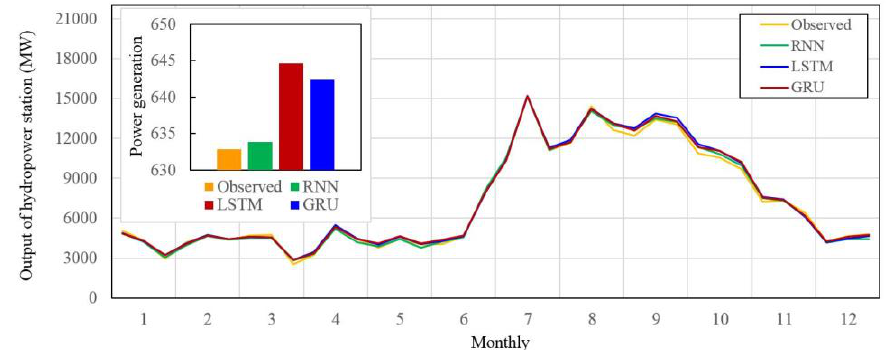
Figure 10. Reservoir daily water level changes comparison between observed water level changes (yellow) with the calculated results with RNN (green), LSTM (blue), and GRU (red).